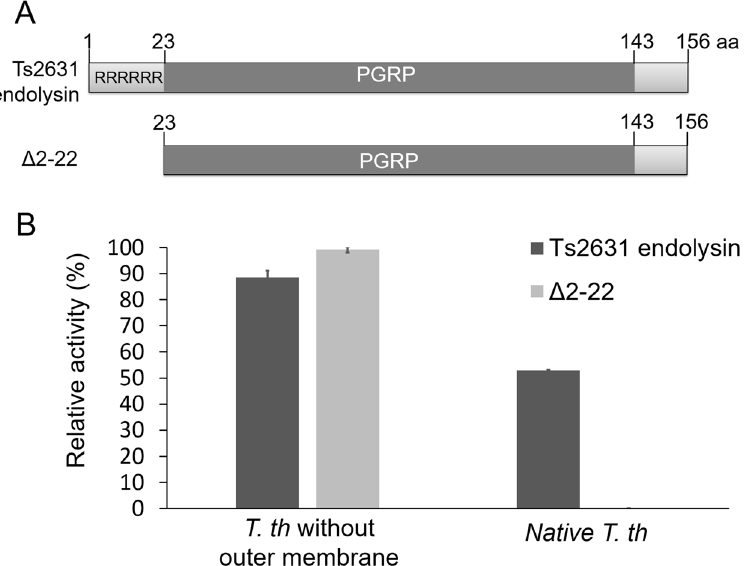
Figure 8. Activity of the full-length and deletion derivative of Ts2631 endolysin. ( A ) The schematic maps of the full-length and deletion derivative of Ts2631 endolysin. RRRRRR – N-terminal arginine rich region. PGRP – peptidoglycan recognition domain (also known as type 2 amidase domain). ( B ) Mutant activity was measured in a standard turbidity assay against chloroform-treated and intact T. thermophilus HB8 substrate at 60 °C. Activities are expressed as percentages relative to the maximal lytic activity achieved for Δ 2-22 variant. Error bars indicate the standard deviation (n = 3).